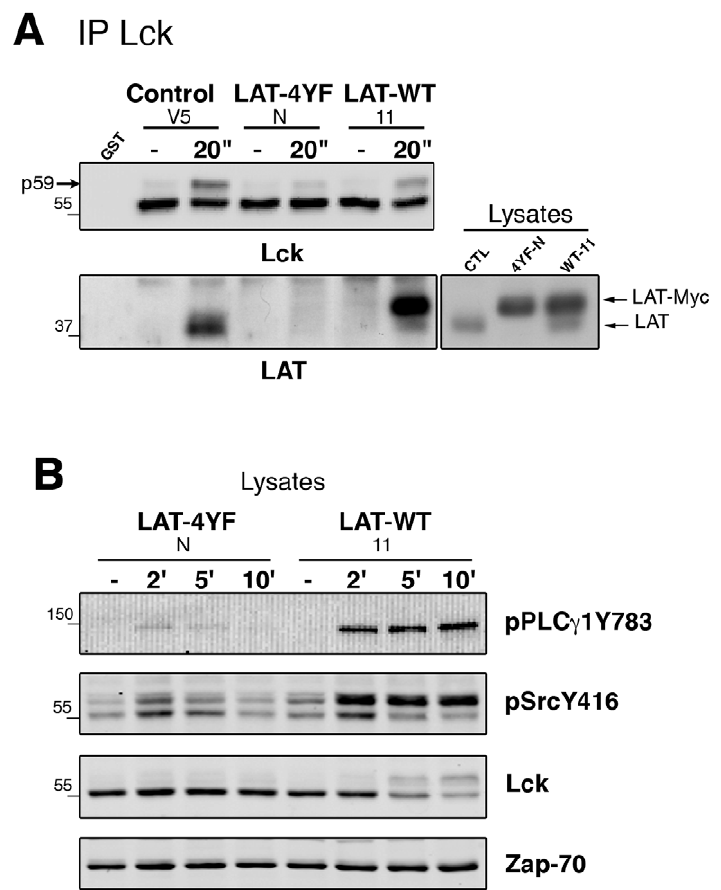
Figure 5. TCR-inducible Lck/LAT association and Lck/Fyn activatory tyrosine phosphorylation depend on LAT tyrosines. (A) Hut-78 cells overexpressing LAT (LAT-WT), LAT-4YF and control cells were stimulated by crosslinking anti-CD3 for 20 s ( 0 ). Lck immunoprecipitates were probed with anti-Lck (upper panel) and anti-LAT Abs (lower panel). An aliquot of cell lysates was kept to monitor the expression of endogenous LAT and myc-tagged LAT (right panel). (B) Cell lysates from CD3-stimulated cells were immunoblotted with Abs against pPLC c 1, pSrcY416 and Lck and Zap-70 for protein loading.